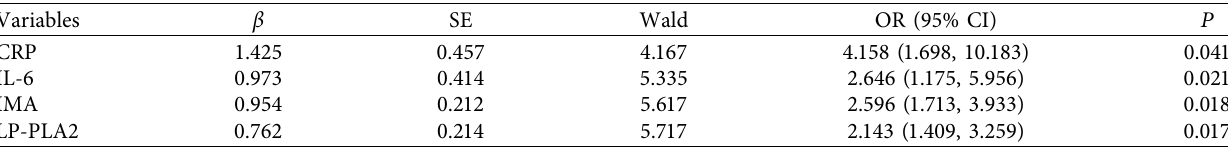
Table 3: Multivariate ordered logistic regression analysis of factors influencing the degree of myocardial ischaemia in patients with CHD.